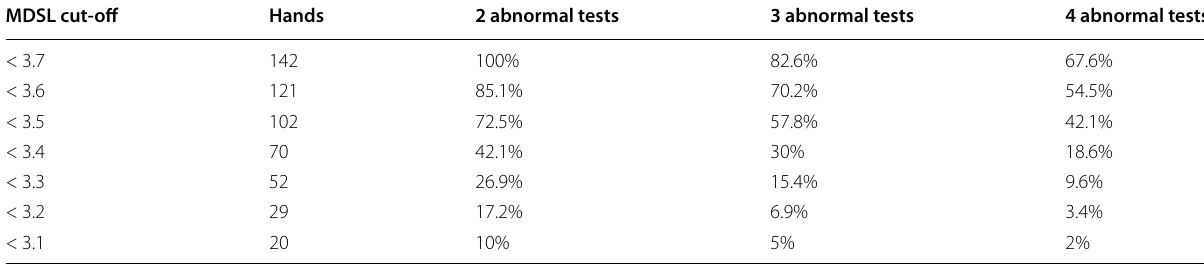
MSPL , median sensory peak latency